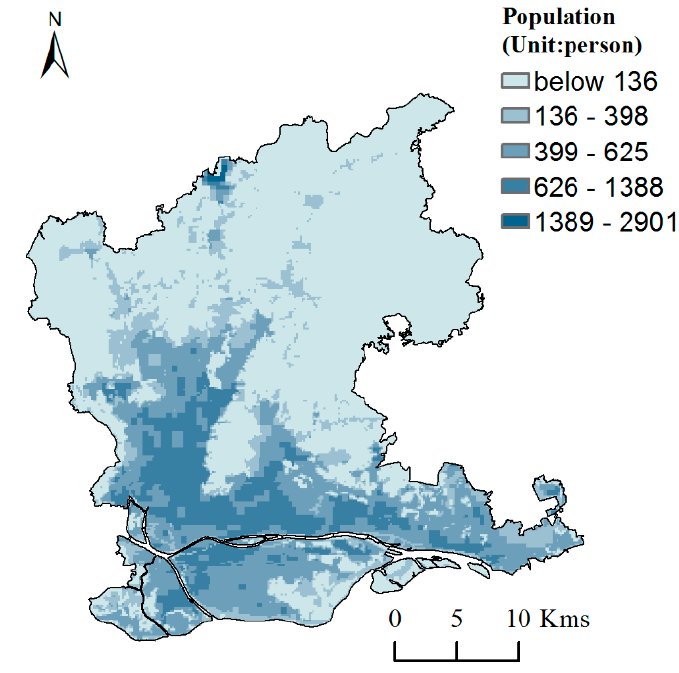
Figure 4. Simulation result by using global linear regression model.